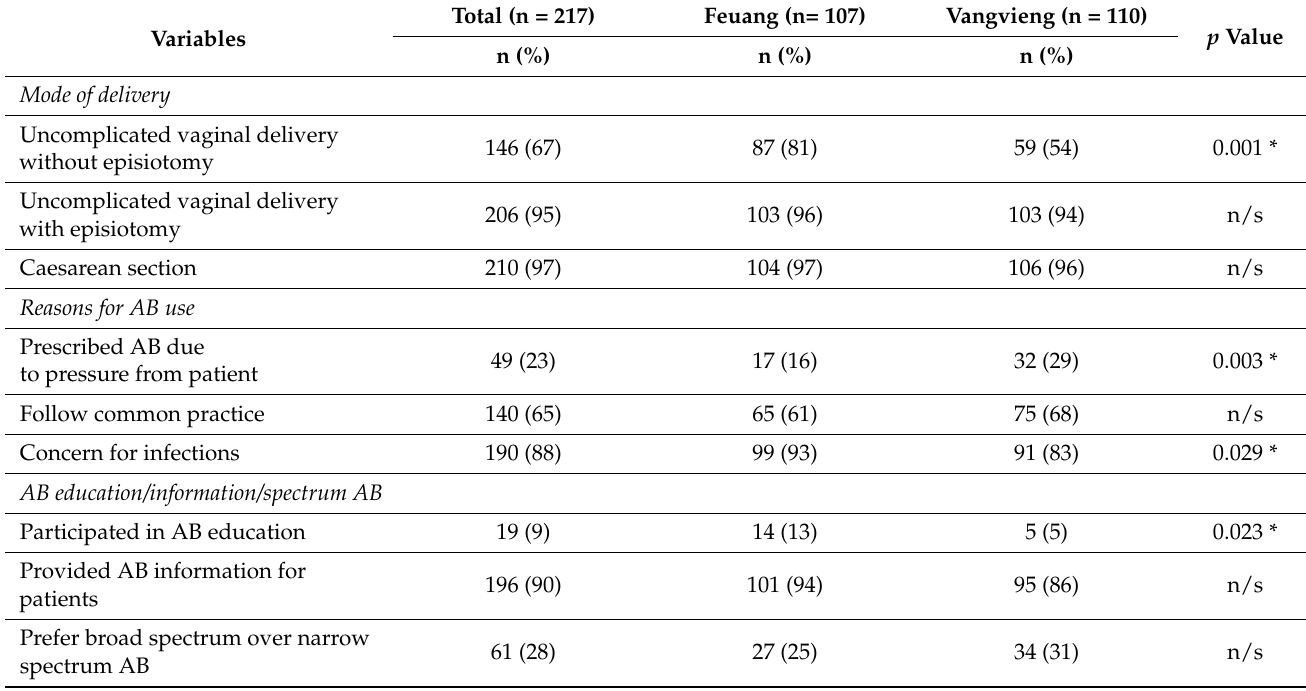
Table 4. Reported practices of participants regarding antibiotic prescribing/dispensing.